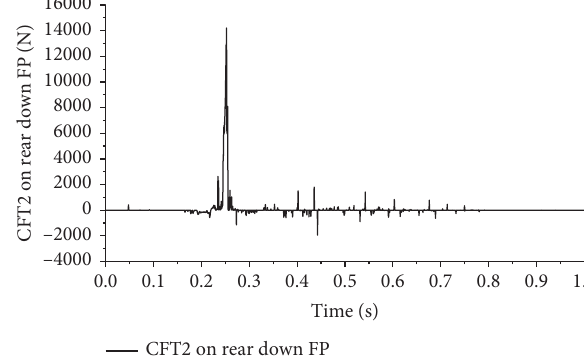
Figure 25: Load time domain curve of fuse pins at rear connection point—vertical impact.